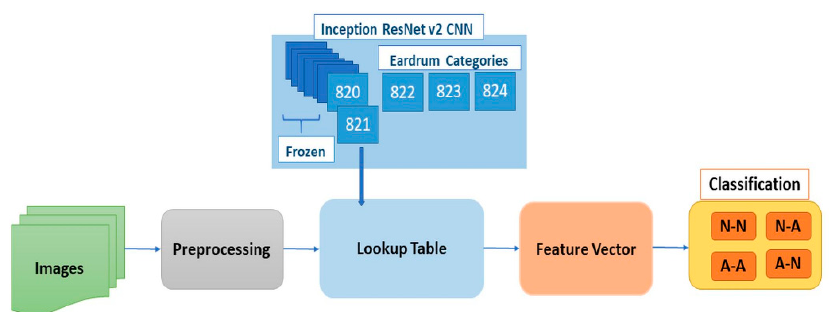
Figure 1. Block Diagram of OtoPair System. Dataset: Train and Validation images, Preprocessing: remove black margin and time text, Lookup Table: generated using Inception ResNet v2 (first 819 layers are frozen, last five layers trained, the values taken from the layer 821st and last three layers updated for eardrum categories), Feature Vector: generated by using pair eardrum images lookup table values, Classification: classify the pair of eardrum images (N-N: Normal-Normal, N-A: Normal-Abnormal, A-A: Abnormal-Abnormal, A-N: Abnormal-Normal).